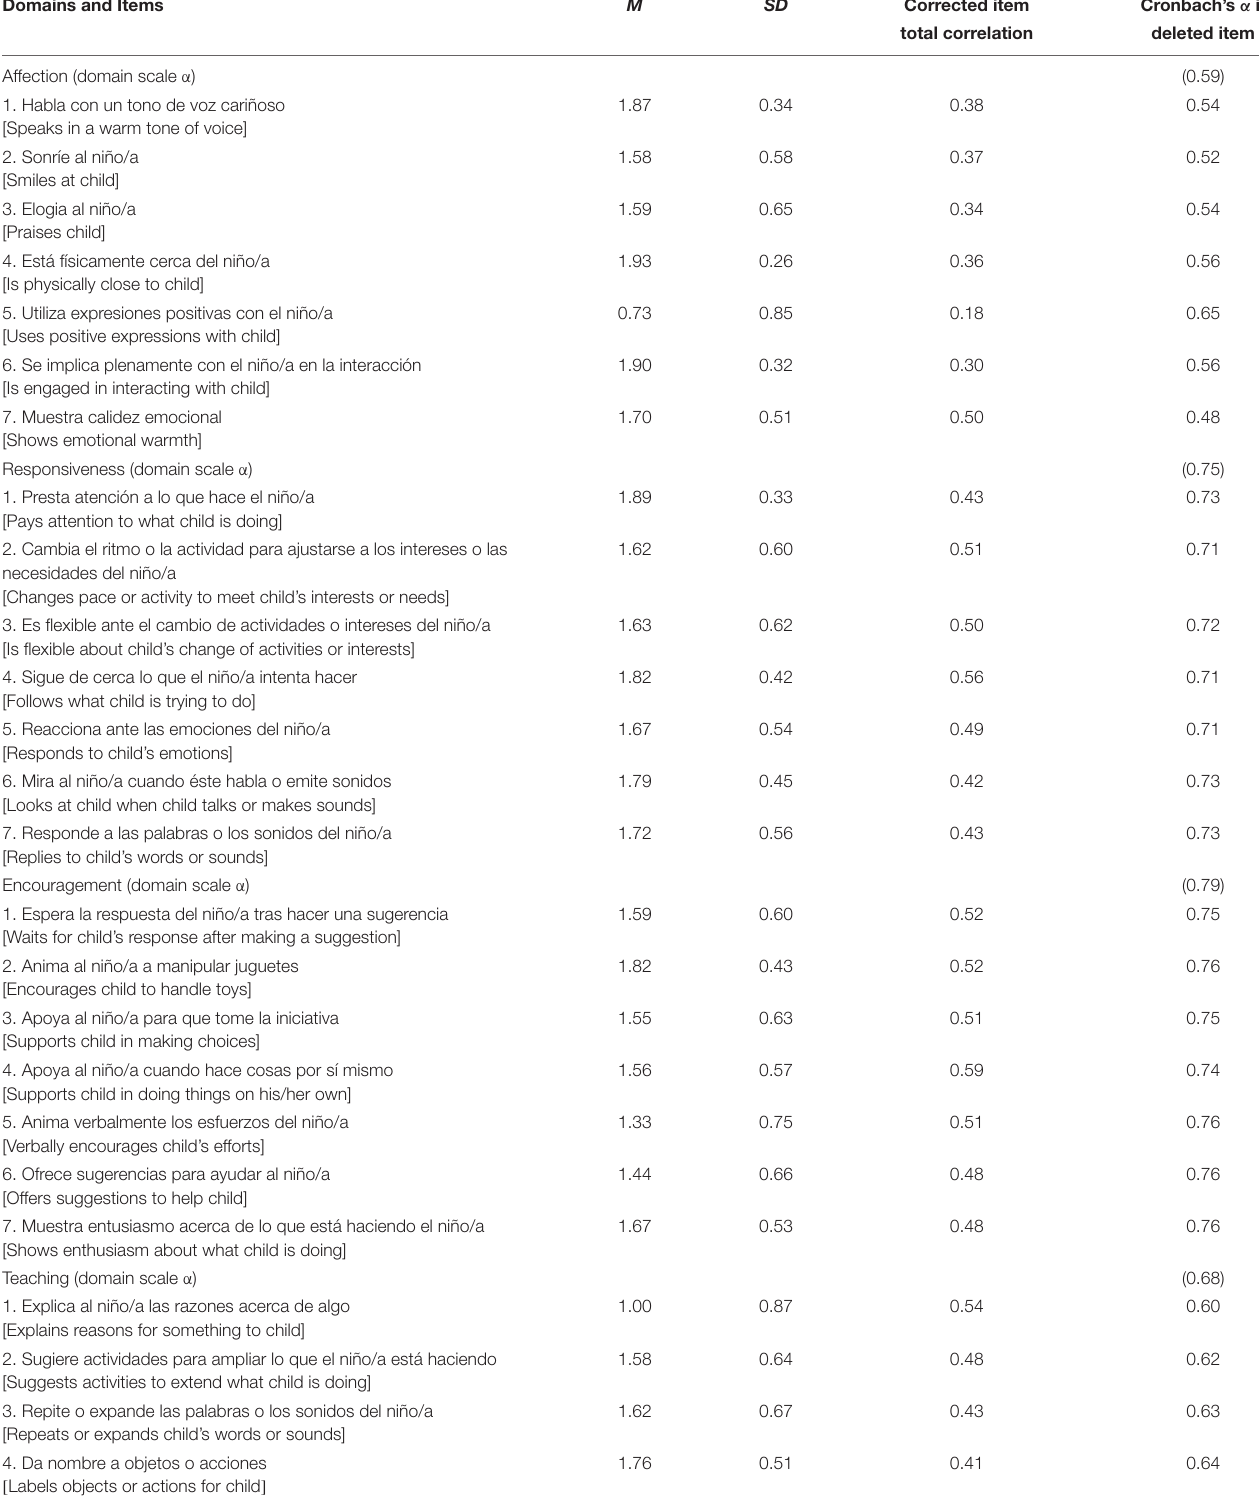
TABLE 1 | Item analysis of the Spanish version of the PICCOLO ( N = 203) (both in English and Spanish). Domains and Items M SD Corrected